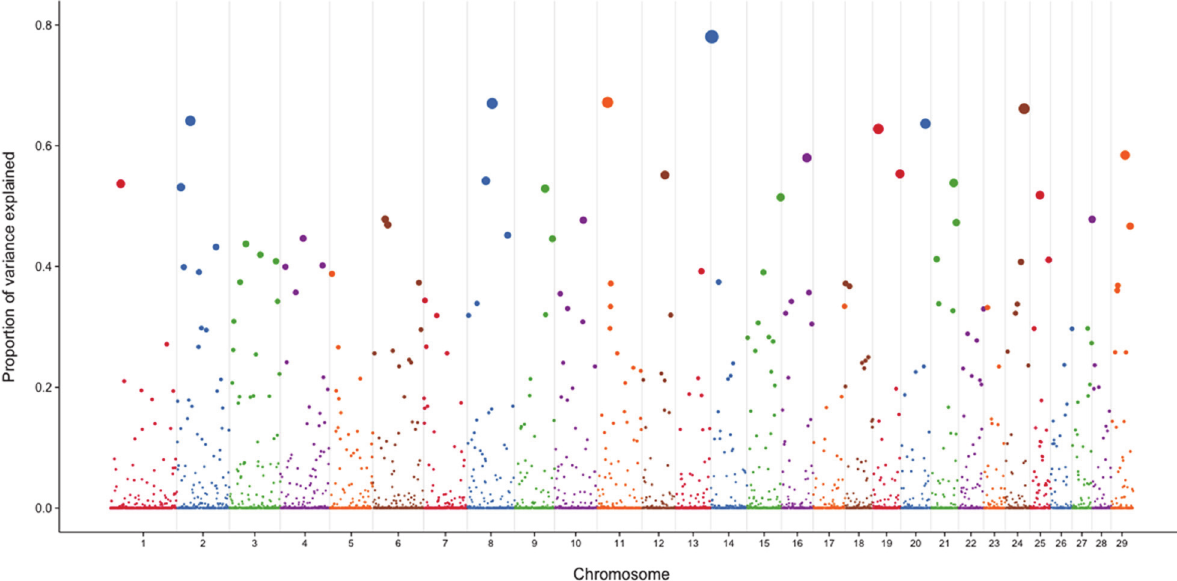
Fig 1. Manhattan plot for the proportion of genetic variance explained by the 10-SNP moving windows. Values on the y-axis sum up to ‘ 1 ’ .